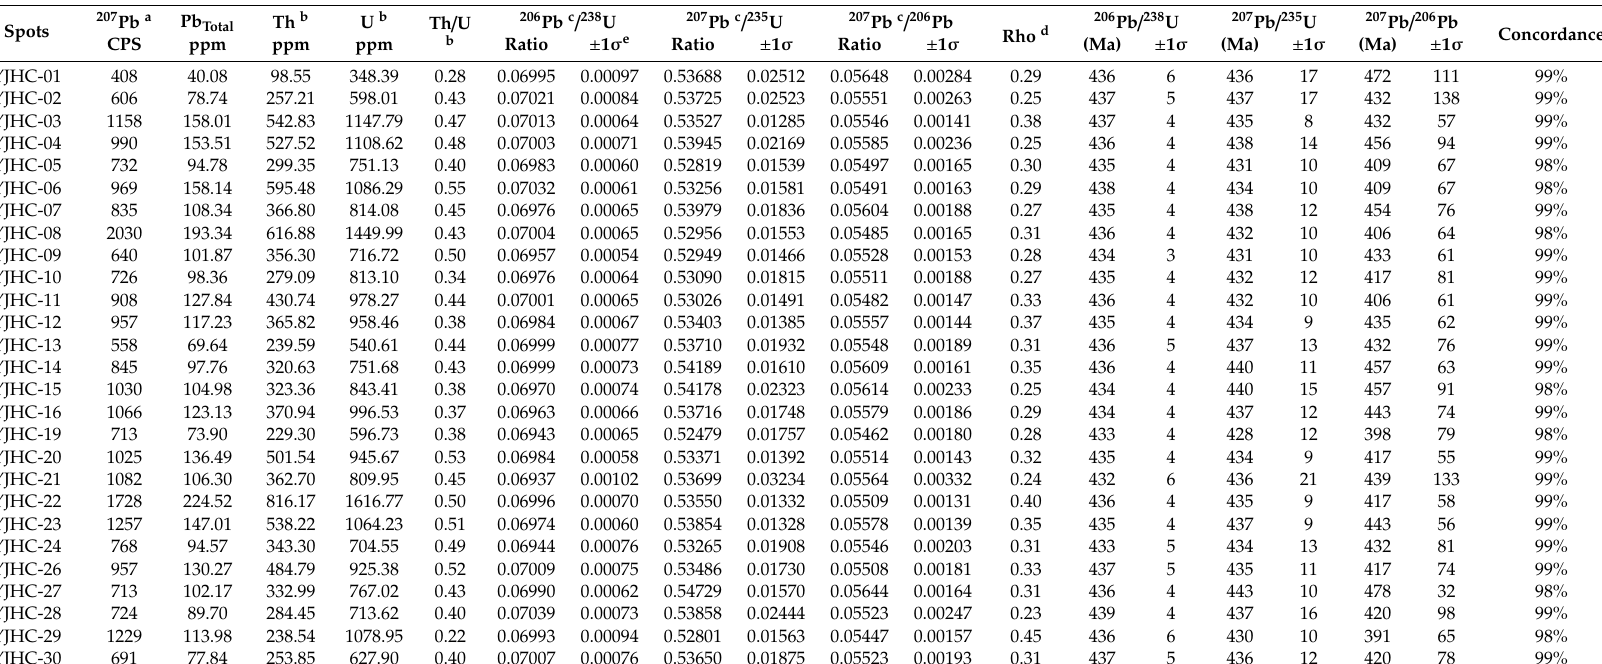
Table 2. LA–ICP–MS zircon U–Pb isotopic ratios and apparent ages of the zircons from Yuejingshan